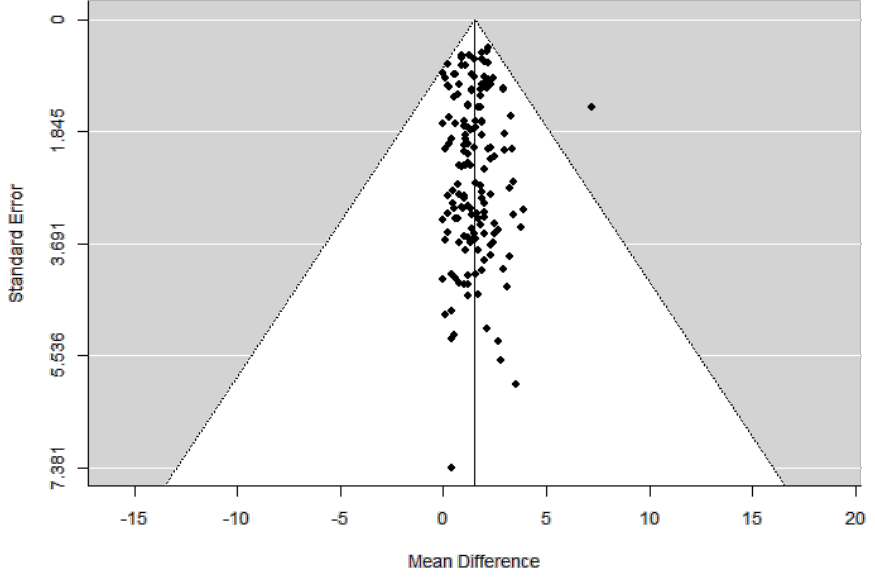
Figure 2. Test for funnel plot asymmetry of the change of muscle mass (all variables measured: FFM, LMM, SMM) after resistance training.